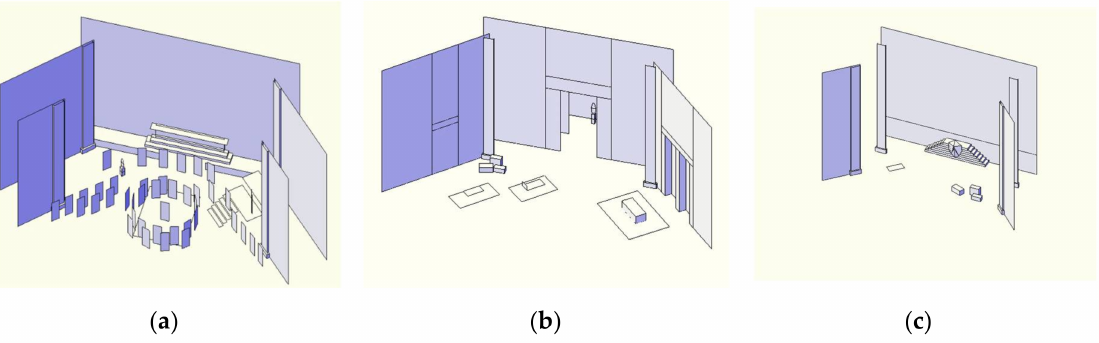
Figure 11. Reconstruction of the scenery of Tosca realized for the Teatro Massimo of Palermo (2022): Act I ( a ), Act II ( b ), Act III ( c